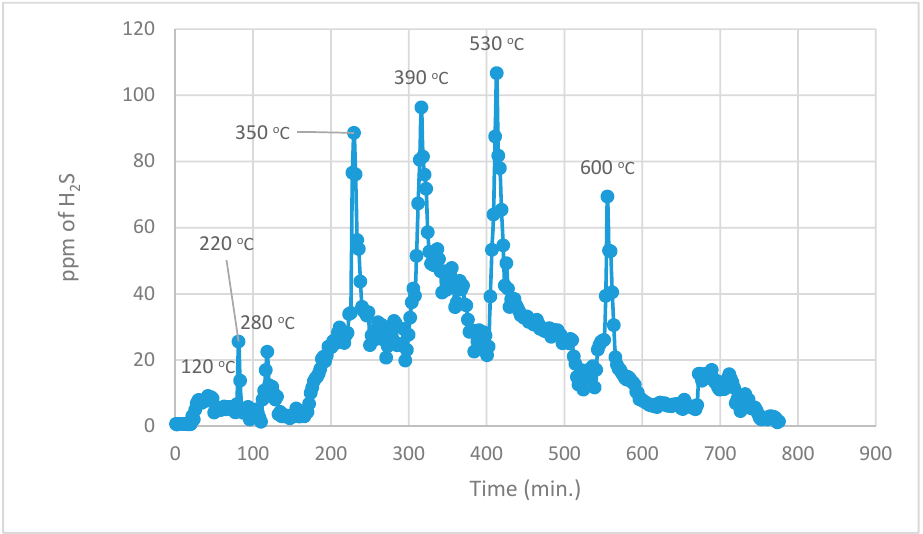
Figure 7. TPR of treated POW1 coal.